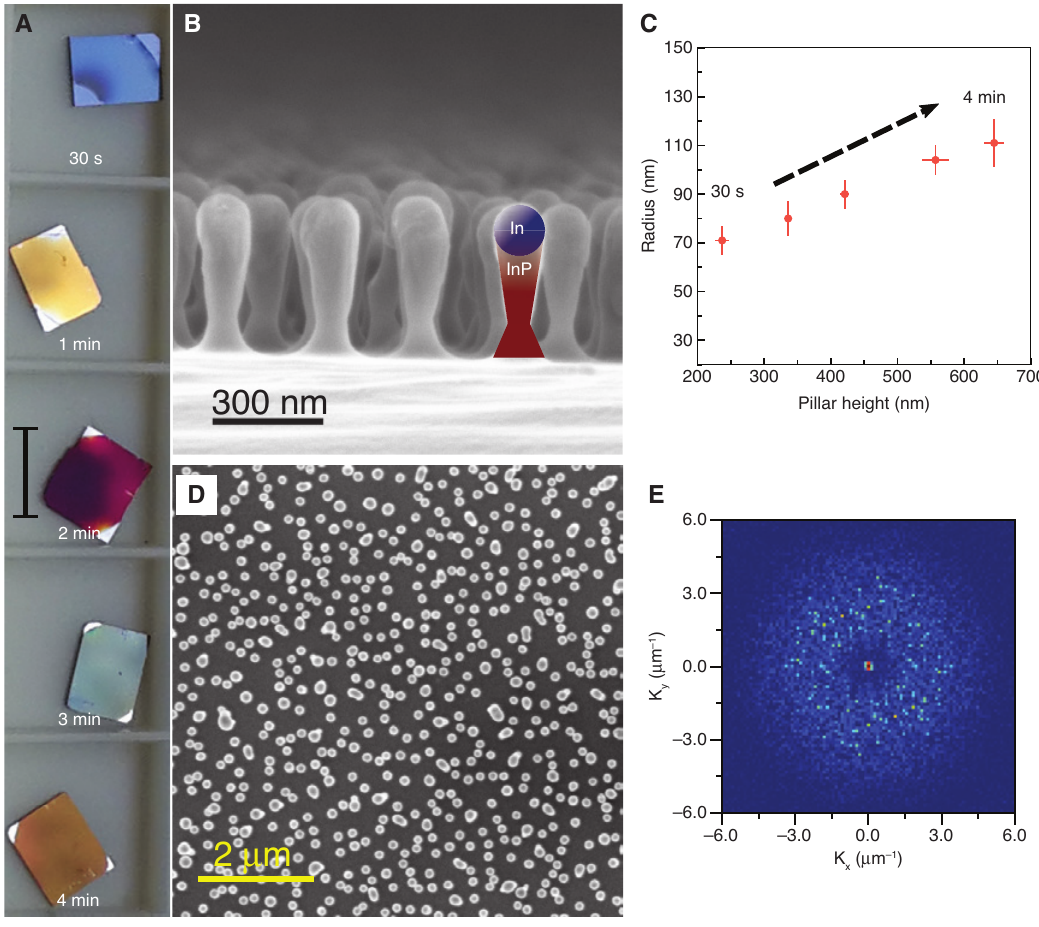
Figure 1: Morphology and spatial distribution of DNPAs. (A) The camera images showing the reflective colors from different In/InP DNPAs fabricated by ion sputtering for different time durations. The scale bar on the 2 min sample image corresponds to 1 cm. (B) Representative cross-sectional scanning electron microscope (SEM) image of the In/InP nanopillars. The inset shows a simple schematic of the formed nanopillar with In-rich capping. (C) Relations between the nanopillar radii (as measured from top-view SEM) and their heights. (D) Representative top view SEM image of the In/InP nanopillars suggesting a disordered spatial arrangement. (E) The FFT of the SEM image in (D) is isotropic, demonstrating the disordered spatial arrangement of the nanopillars; the spatial frequencies span the visible wavelength